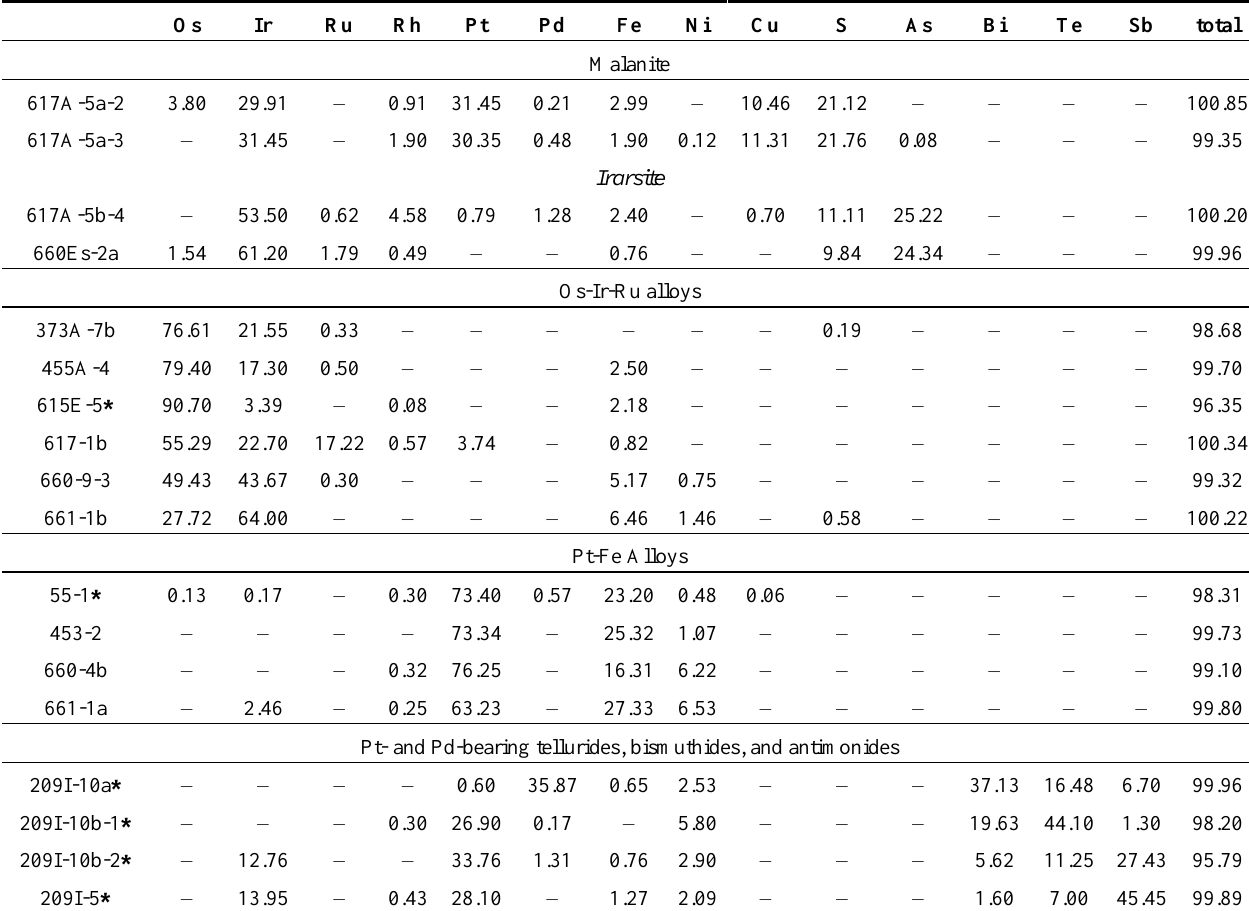
Table 3. Electron microprobe compositions of PGM sulfides, sulfarsenides, alloys and bismuth-tellurides from